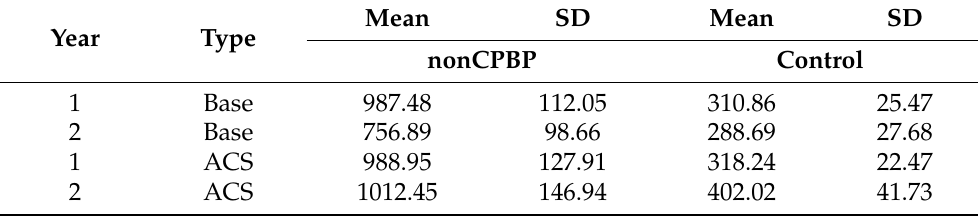
Table 1. FSF predictions with the nonCPBP data, under base and ACS (Annual Cyclical Scenario) Economic Stress. The means and standard deviations for 25 independent runs are shown in each case.